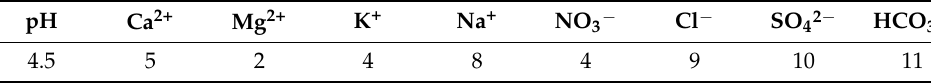
Table 2. Chemical composition of the soil in this work (mg/kg soil).